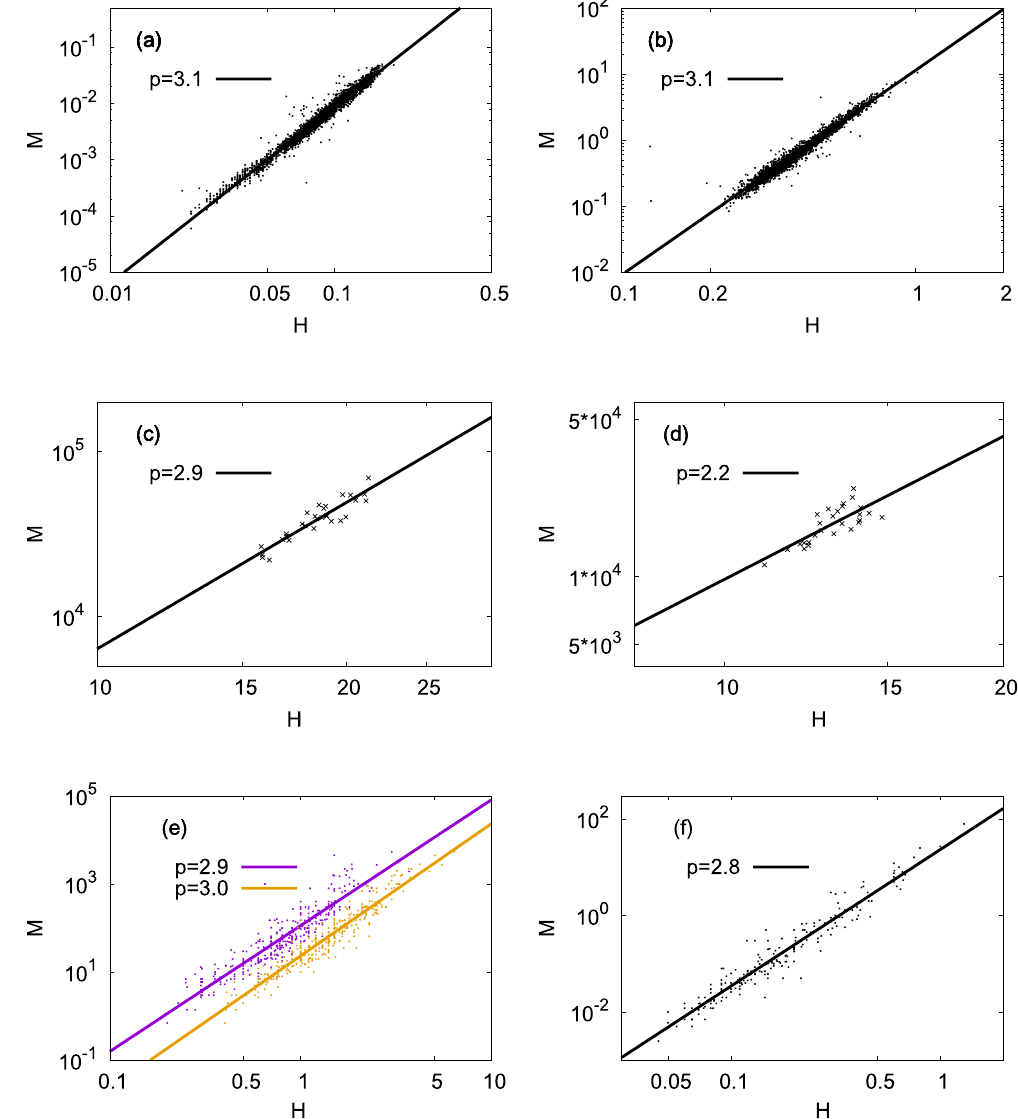
Figure 1. The mass M versus the linear body size H of animals: ( a ) Pale chub ( Zacco platypus ) ( N = 3 163) and ( b ) Korean chub ( Zacco koreanus ) ( N = 997) are for fishes, ( c ) Fin ( N = 29) and ( d ) Sei ( N = 27) are for whales, and ( e ) and ( f ) are for land mammals, respectively. The data file used for ( e ) contains all 325 lines of the mass, the body length, and the shoulder height information of many different species of land mammals, while the file used for ( f ) contains 205 lines of the mass and the body length of species in order Rodentia. In ( e ) two different ways to measure the linear size, the shoulder height (upper points) and the body length (lower points) are displayed. In all datasets in ( a )–( f ), we observe that the Benn index p ≈ 3, with ( d ) an exception, probably due to insufficient data size for Sei